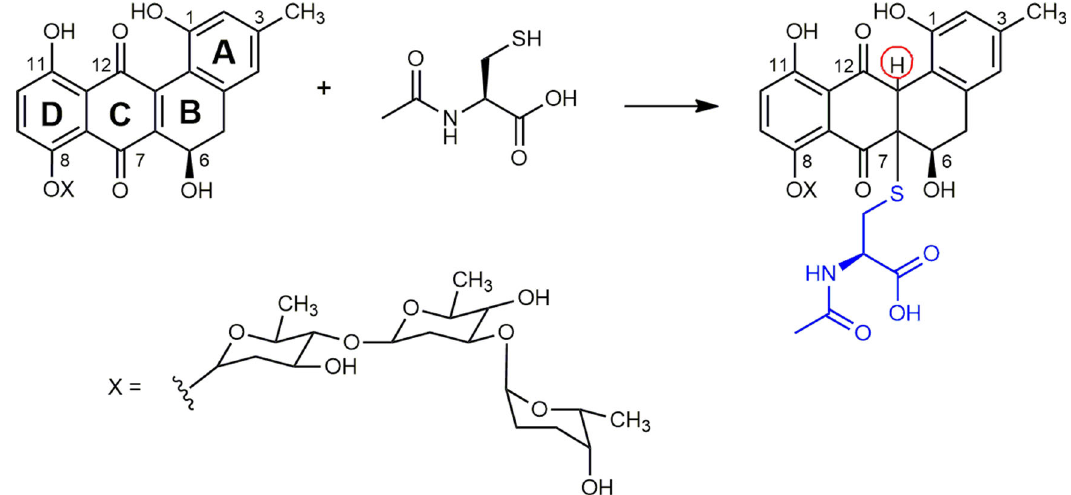
Fig. 4 LE – NAC adduct formation. Reaction scheme of LE and NAC and proposed structure of the formed